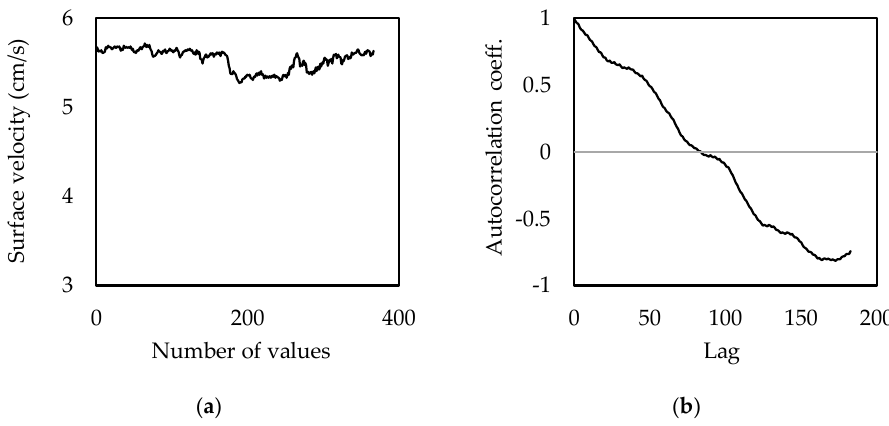
Figure 8. ( a ) The succession of measured velocity values leading to the mean velocity marked with an arrow in Figure 9; ( b ) the corresponding autocorrelation function (lag expressed in terms of number of values).